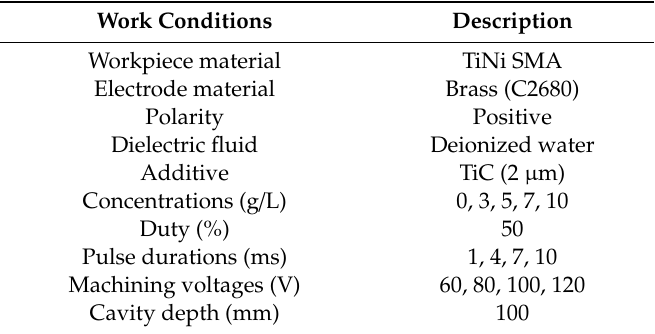
Table 1. Experimental